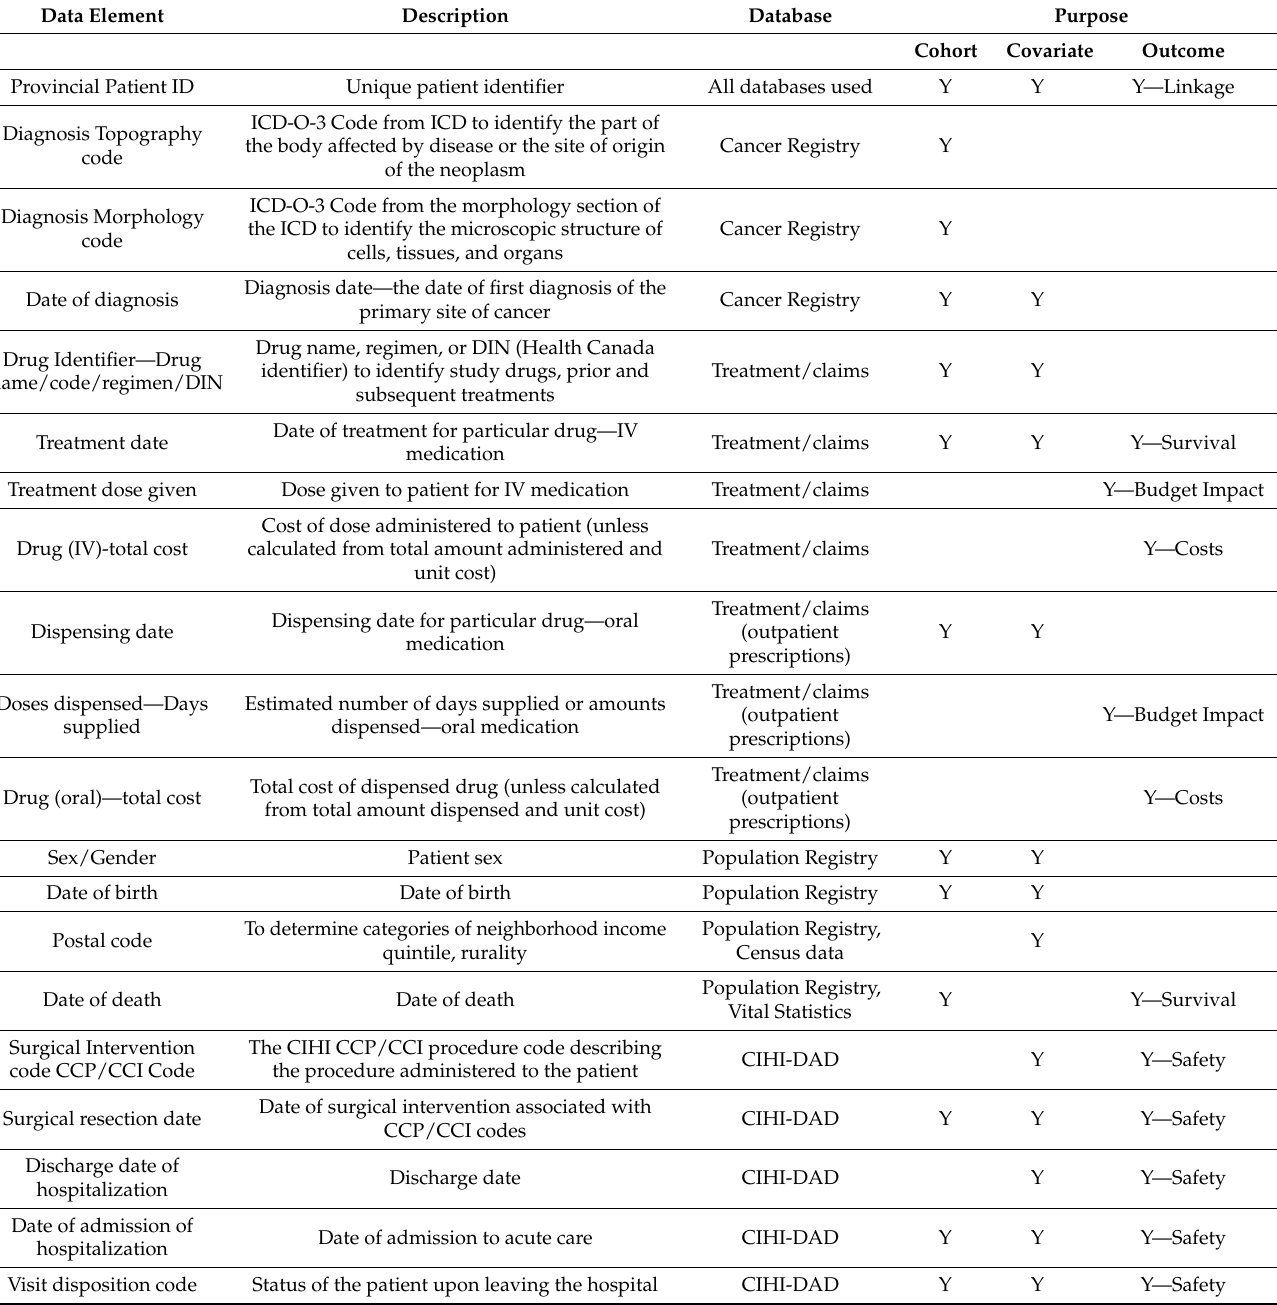
Table 3. Essential Cancer RWD